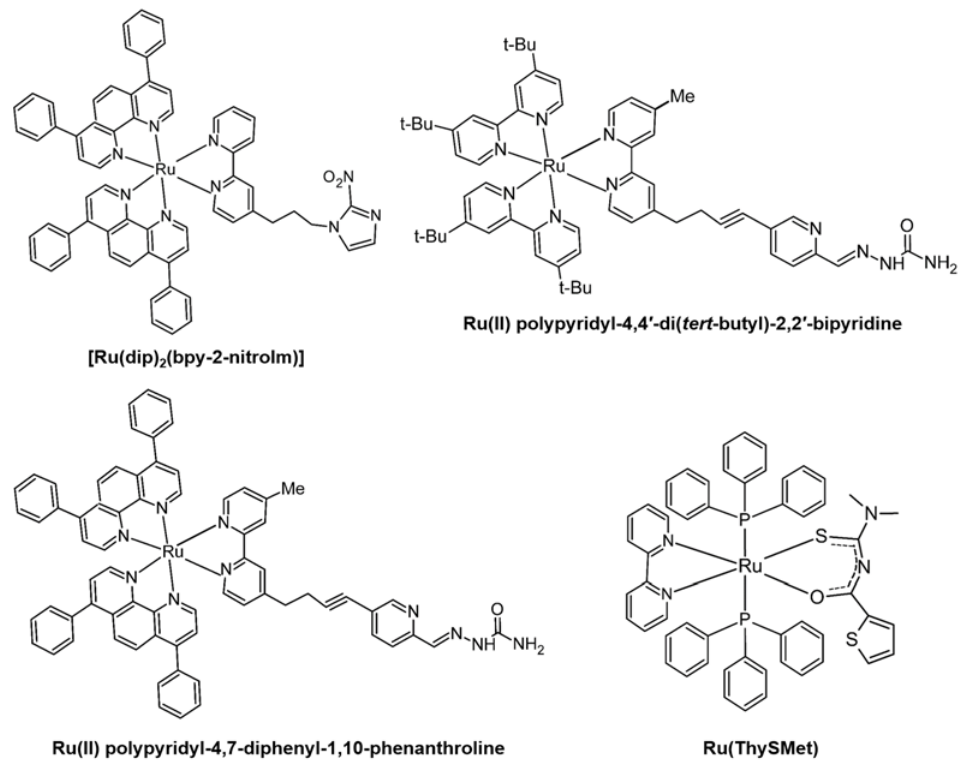
Figure 5. Ru(II) complexes regulating the activity and expression of MMPs.